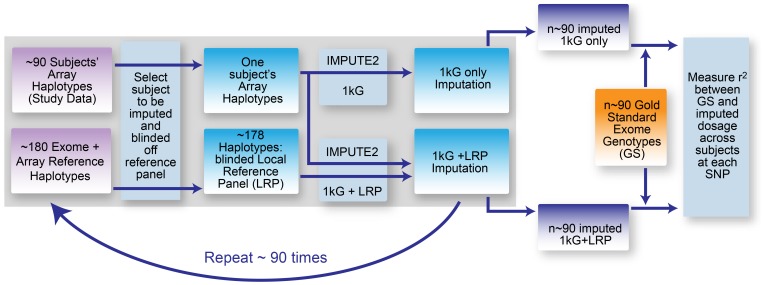
Illustration of the procedure to estimate imputation accuracy.We used a drop one-out crossvalidation approach. For the imputation step each subject was removed from the reference panel in turn, and this subject’s exome sequence SNPs were then imputed using either the 1000 Genomes reference panel alone or in conjunction with a second local reference panel. All subjects’ imputed allelic dosages were then compared with the exome sequence genotype data (“gold standard”).